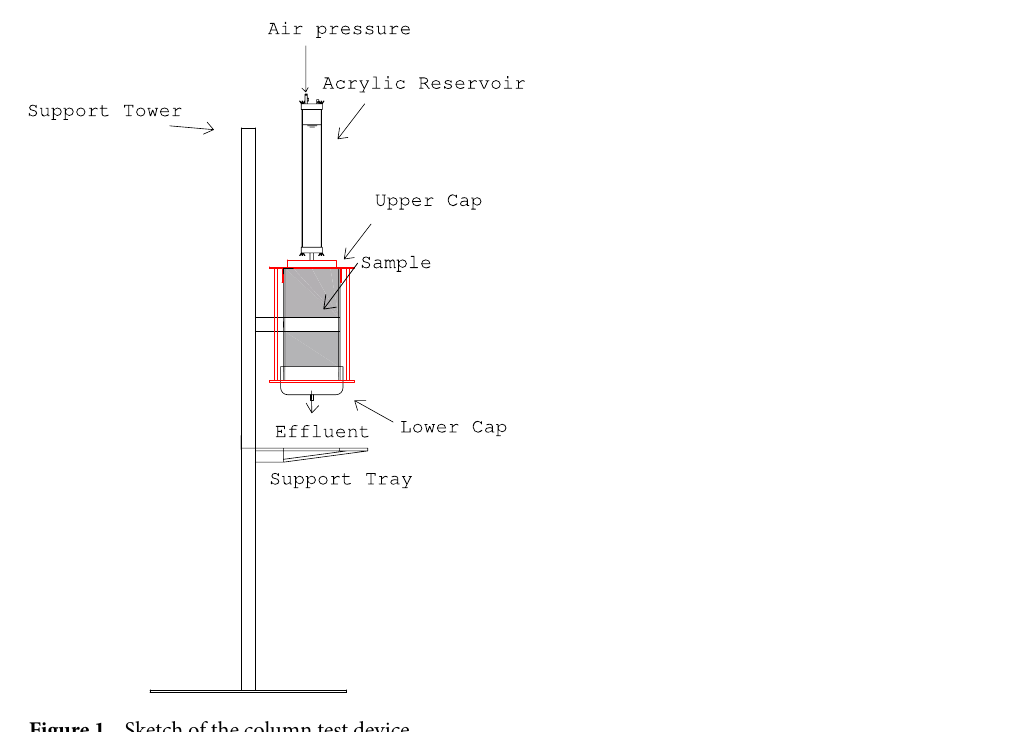
Figure 1. Sketch of the column test device.